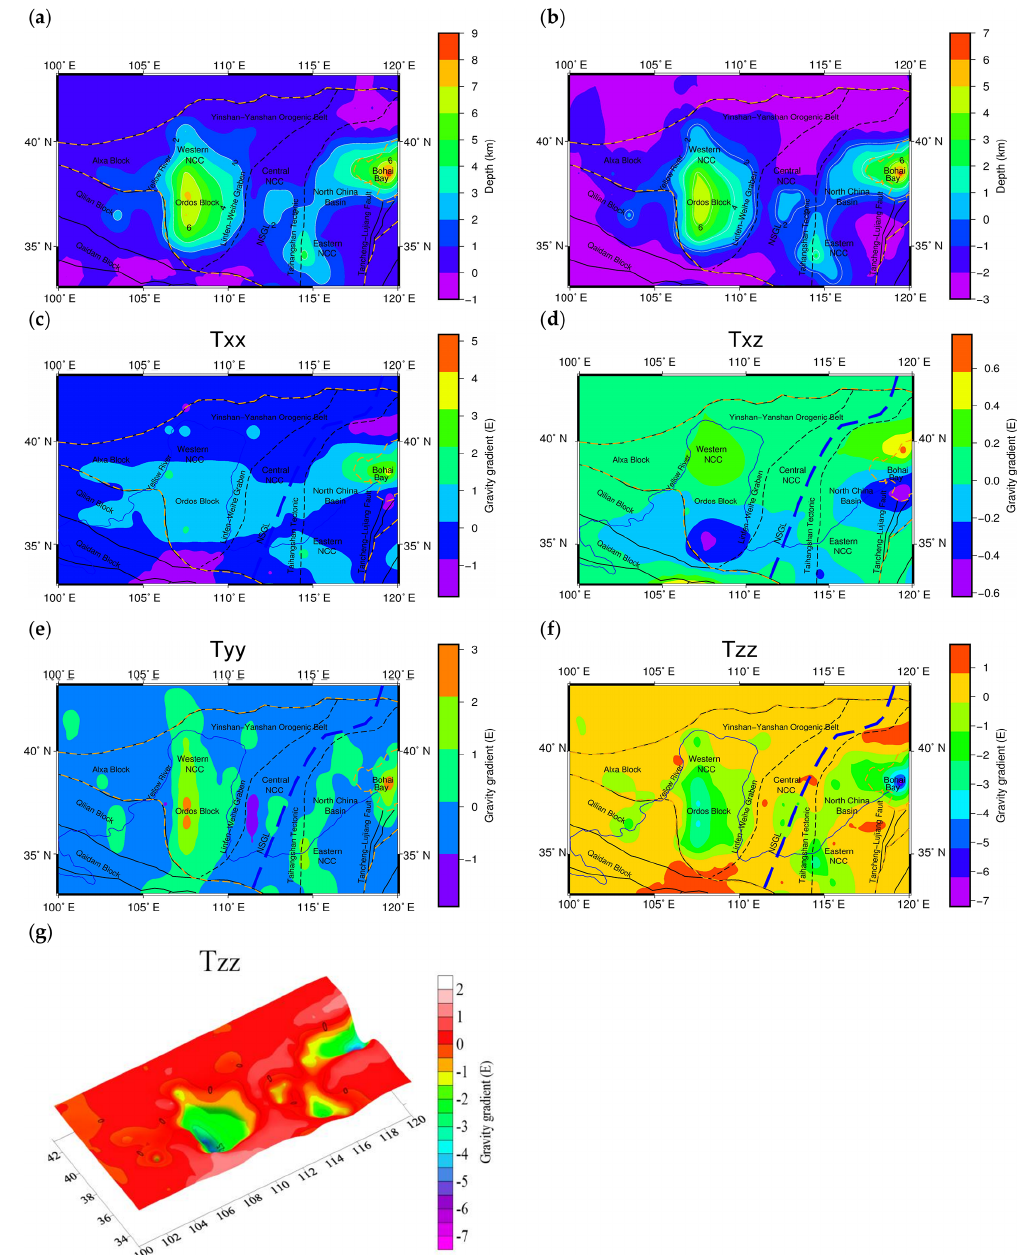
Figure 10. (a) Sedimentary layer interface of the NCC. (b ) Sedimentary layer interface undulation of the NCC. The anomalous gravity gradient component caused by the relief at the sedimentary layer interface undulation are shown in (c ) T xx , (d ) T xz , (e ) T yy and (f ) T zz . (g ) The 3D gravity gradient effect T zz of the sedimentary layer interface undulation is